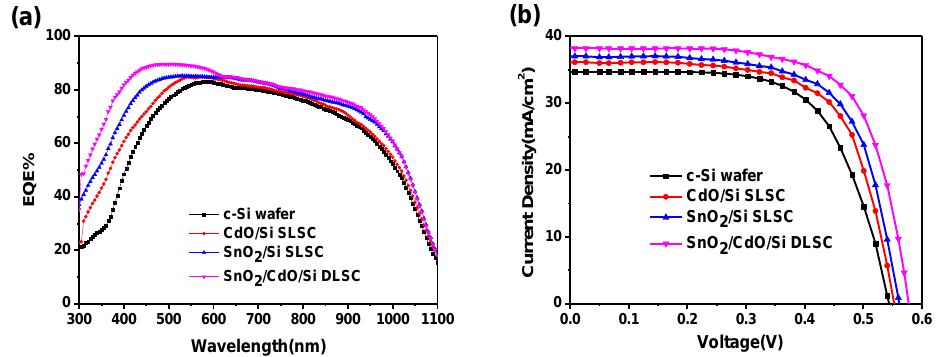
Figure 4. ( a ) External quantum efficiency (EQE) spectra and ( b ) J-V characteristics for blank c-Si solar cell, CdO/Si, SnO 2 /Si SLSCs, and SnO 2 /CdO/Si DLSC.